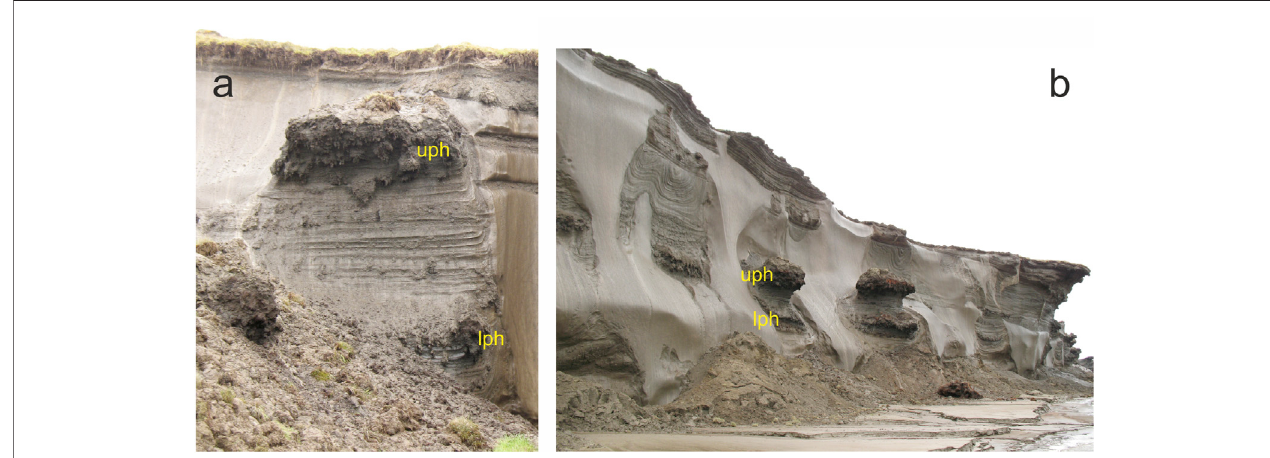
FIGURE 8 | Bychchagy Ice Complex deposits with two horizons of polygonal autochthonous peat lenses: (A) Oyogos Yar (height of outcrop is 3 m) and (B) Bol`shoy Lyakhovsky Island (uph – upper peat horizon, lph — lower peat horizon; height of outcrope is 12 – 15 m).